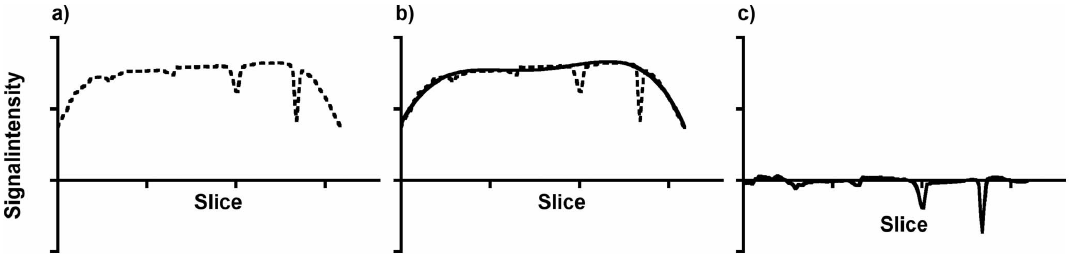
Figure 3. Demonstration of the fitting of the signal intensity curve to eliminate artificial effects due to sequence, gradient, and field inhomogeneities. Each value on the x-axis represents one slice of an aquired sequence. The datapoints on the x-axis therefore may vary from sequence to sequence, depending on the amount of aquired slices. The mean signal intensity per slice (as by ROI analysis) is shown for each individual slice on the y-axis, resulting in a curve with a varying resolution, depending on the amount of slices of each sequence. The original data is shown in (A). Negative peaks of signal loss indicate cell-containing layers. A signal inhomogeneity along the B 0 axis corresponding to the long axis of the agarose phantom is superimposed, resulting in a drop of signal intensity in the first and last slices of the sequence. To remove this signal inhomogeneity without compromising cell derived peaks for further analysis a curve was fitted to the data after removal of the cell bearing slices (B) and subsequently subtracted from the original data which resulted in a straightened curve, showing the peaks on a linear baseline